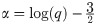
Kolmogorov-Smirnov statistic values obtained by fitting a power law and negative binomial model to absolute cascade size data.Filled shapes represent the minimum divergence of the two fits, calculated using the Kolmogorov-Smirnov statistic. N = 1000 for all panels. a) K = 1 and negative binomial fits well for q < 0.6, but power law (zeta distribution) is a better fit for q > 0.79, with exponent α=log(q)-32 in this region. b) K = 2 and negative binomial provides a good fit up to q < 0.85. c) and d) show the typical cascade sizes versus q for the case K = 1 and K = 2 respectively.